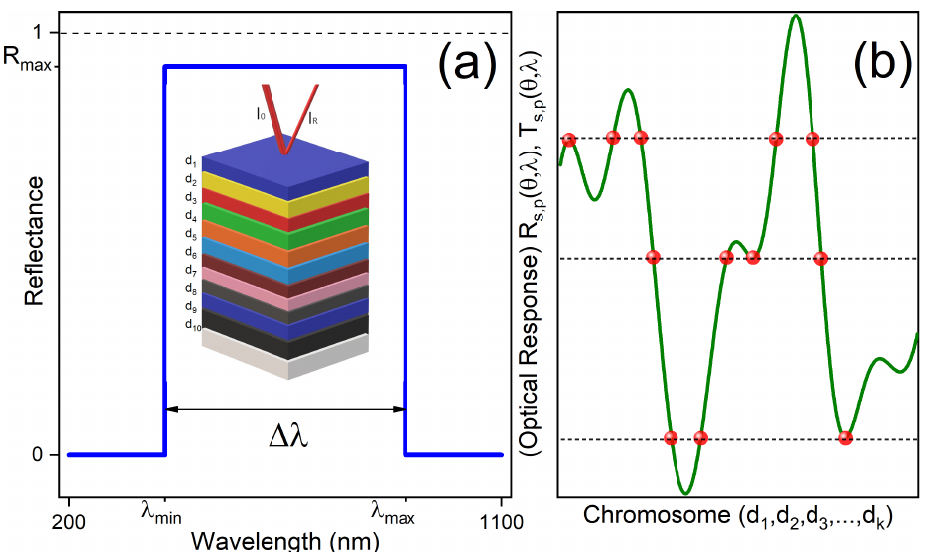
Figure 1. ( a ) Target reflectance spectrum and example of 10-layer designs. ( b ) Design spaced represen- tation of the inverse design of photonic structures that implies a many-to-one problem. Each point in this hyperspace represents a chromosome containing all the layer thicknesses ( d i ) of the photonic crystal sequence and its corresponding optical response (reflectance and transmittance). The graph shows that multiple designs correspond to identical optical responses (indicated by the dashed lines), exhibiting a high